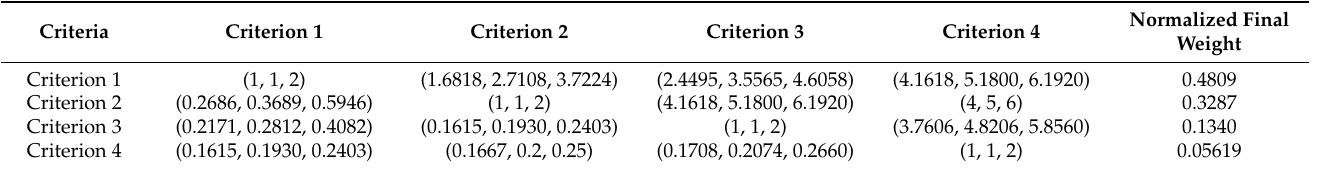
Table 1. Pair-wise comparison and final normalized weights of criteria.